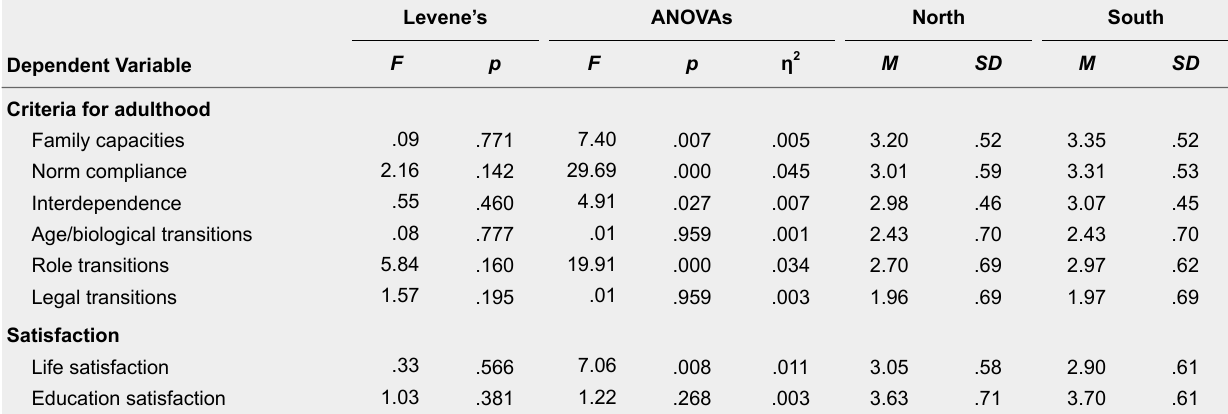
One-Way ANOVAs With Criteria for Adulthood, Life Satisfaction and Educational Track Satisfaction as Dependent Variables and Sub-Group Membership as Independent Variable